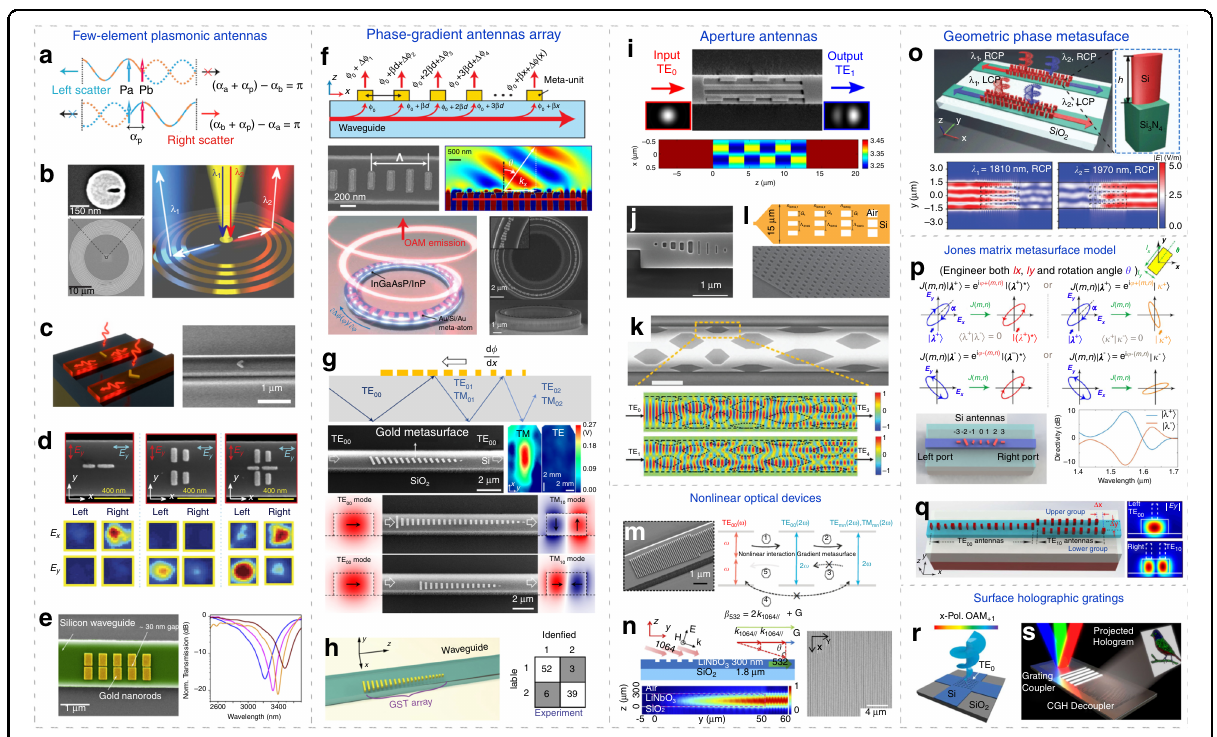
Fig. 3 Dielectric meta-waveguides with surface subwavelength structures. a Dipole interference model for directional emission and coupling 40,48 . b Wavelength-selective demultiplexer by integrating Fano nanoantennas on planar waveguides 49 . c On-chip directional coupler 158 . d Integrated polarization demultiplexer 50 . e On-chip spectroscopic sensor 168 . f Guided wave-driven metasurfaces for modulating free-space light 35 . g Integrated mode convertor by saddling gradient-metasurface on dielectric waveguides 51 . h Programmable metasurface for photonic neural network and experimental results for image recognition 177 . i , j Waveguide mode convertor based on shallow 84 or fully etched 87 metasurface perturbations. k Simultaneous multimode convertor 89 . l Ef fi cient coupler 38 . m Metasurface-assisted second harmonic generation in lithium niobate (LN) waveguide 52 . n Nonlinear signal generation and manipulation in LN waveguide patterned with grating metasurface 155 . o Polarization and wavelength sorting 42 for circular polarizations using Geometric phase metasurface. p Jones matrix model 43 . q Versatile coupler for arbitrary polarizations 44 . r OAM generator using subwavelength holographic surface gratings 45 . s Multi-color waveguide holography 80 . Panels adapted from: Springer Nature 40,52,177 ; ACS 49,84,158,168 ; AAAS 45,50,51 ; Wiley 38,42,87,88 ; OSA 43,44,80,155